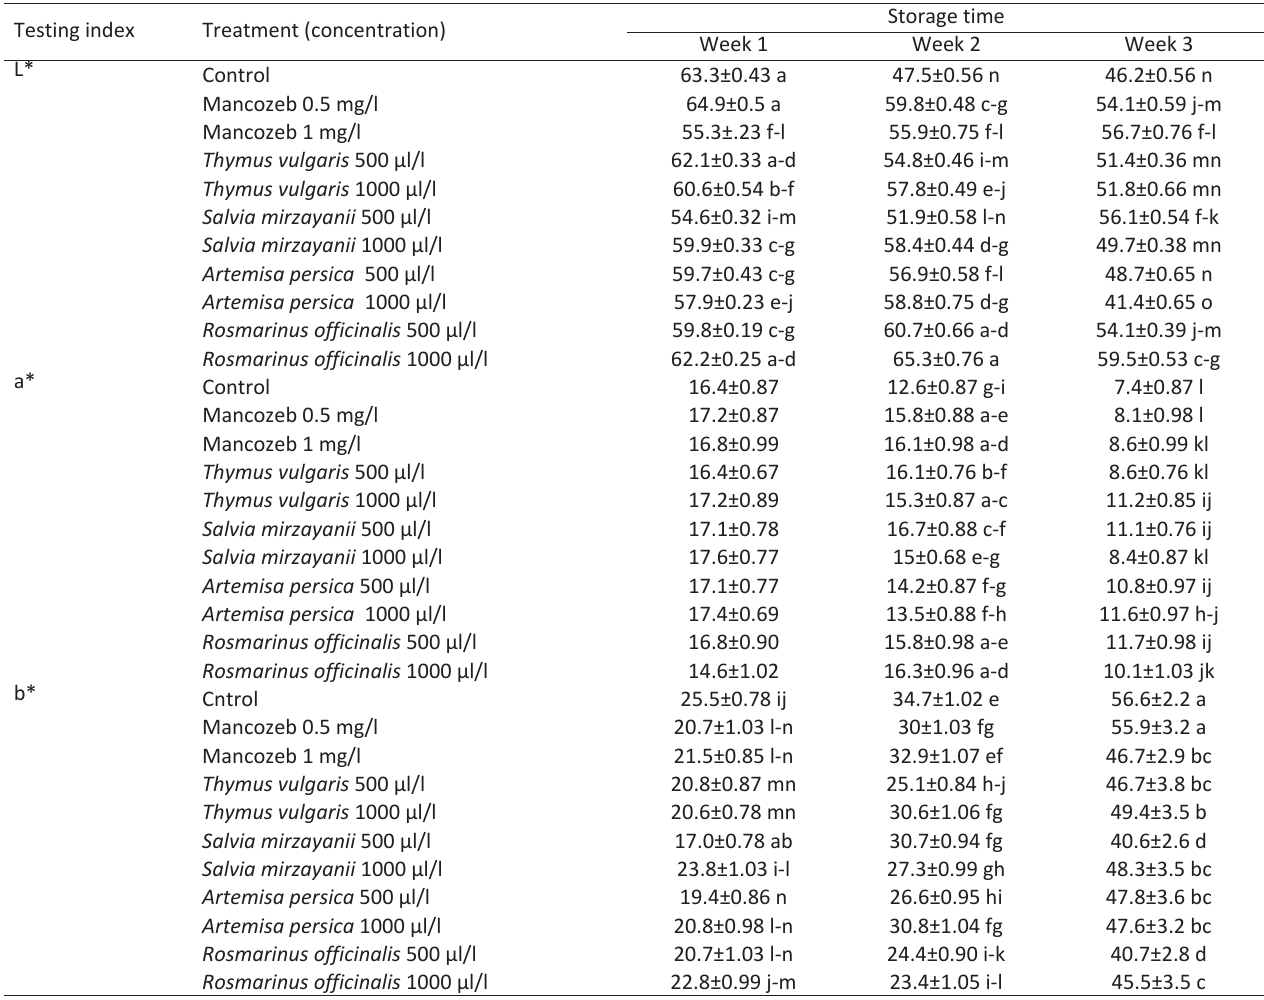
In each character, different letters indicate significant differences in mean